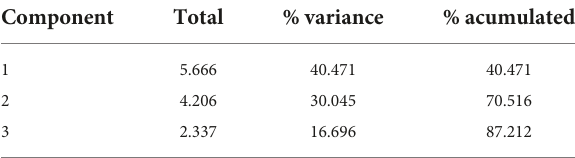
TABLE 5 Three main components that describe the